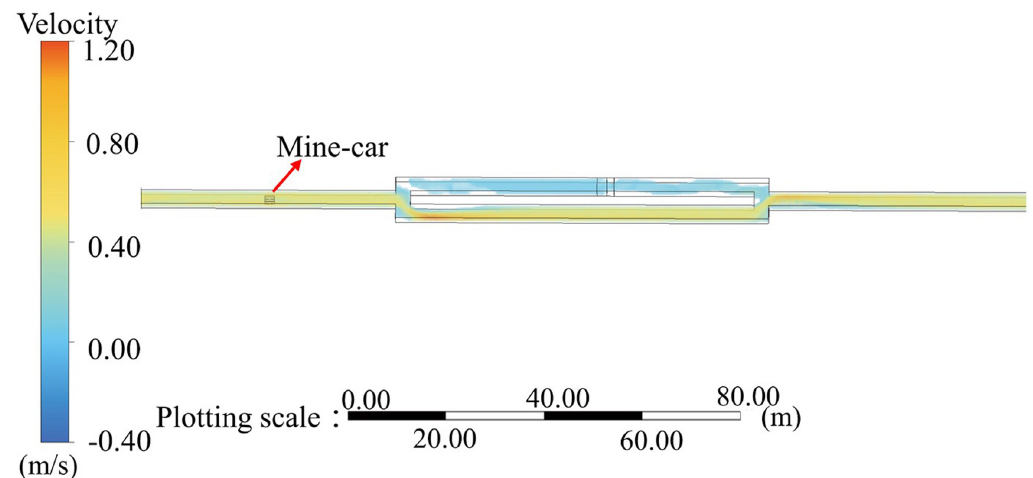
Fig 6. Physical-model numerical simulation parameters and flow-field distribution for 0.49-m/s inlet wind velocity.